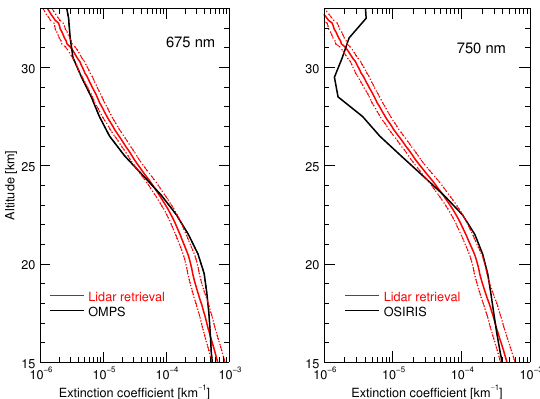
Figure 14. Extinction profiles obtained from the OMPS ( left ) and OSIRIS ( right ) instruments for March 2013. The red solid lines show the lidar extinction profile for March 2013 retrieved with S = 1.5 and converted to the wavelengths of OMPS and OSIRIS using Equation (17). The red dotted lines indicate the error ranges (similar to Figure